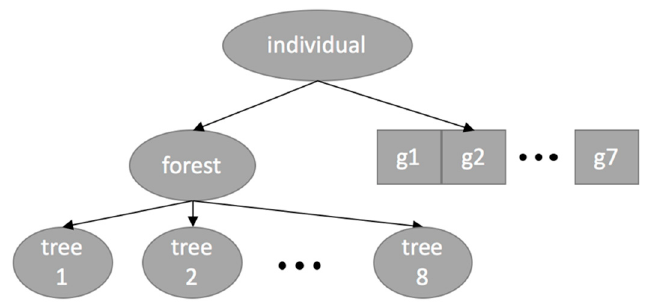
Figure 5. The genetic representation of the evolved individual comprising both the arithmetic expressions of features pertinent to the dynamics of the accelerator pedal (the forest) and the values of the hyperparameters of the classifier (the linear chromosome of seven genes).